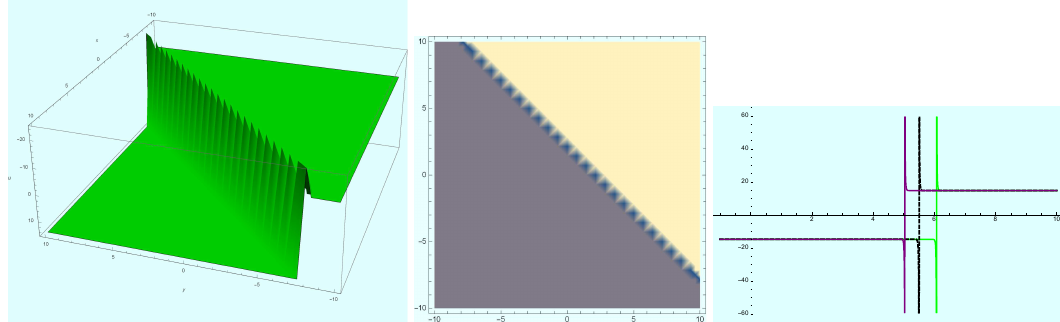
Figure 5. Evolution of traveling wave of singular soliton solution (24) at t = 2 and z = − 3.5.